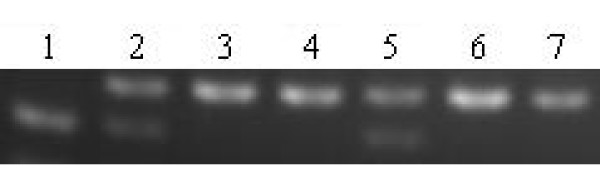
lane 1 represents homozygous CC genotypes, lane 2 and 5 represents heterozygous AC genotypes and lane 3, 4, 6, and 7 represents homozygous AA genotypes of A20C polymorphism of AGT gene.